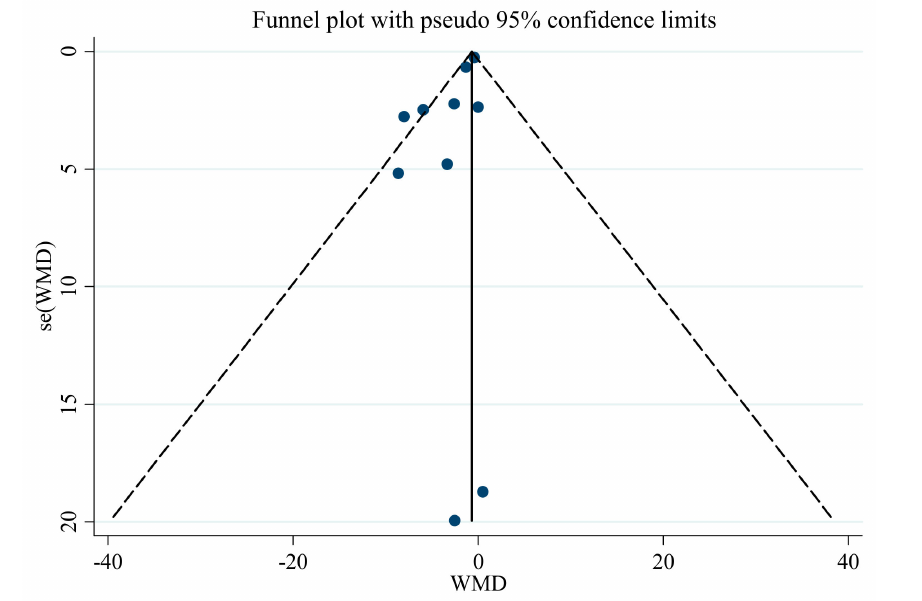
Figure 8. Funnel plot for the effect of saffron supplementation on